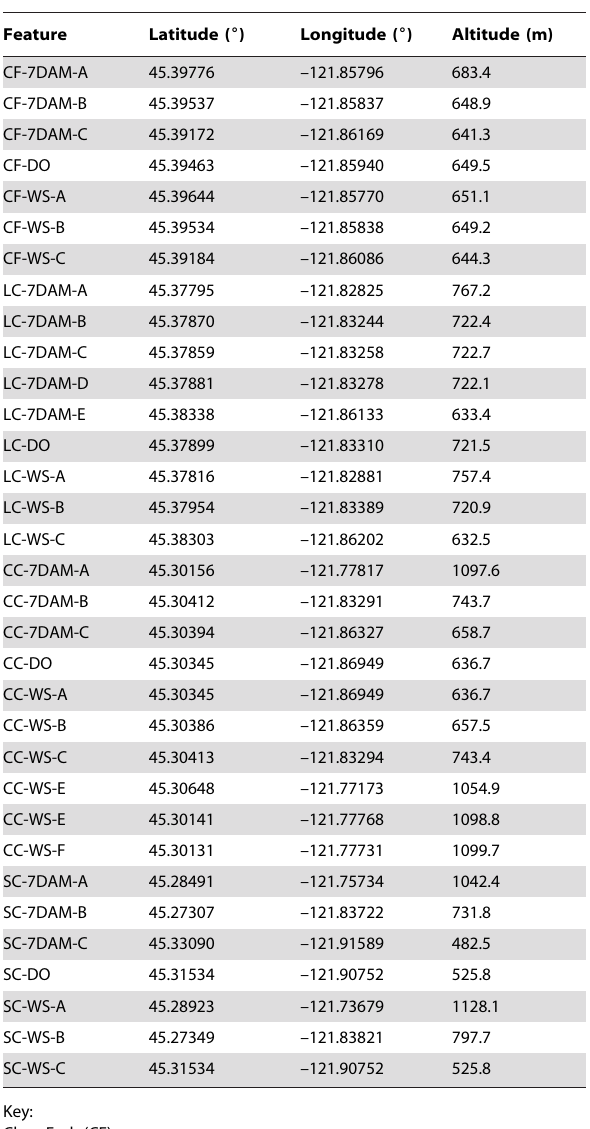
Table 1. Elevations and coordinates of all the sampling